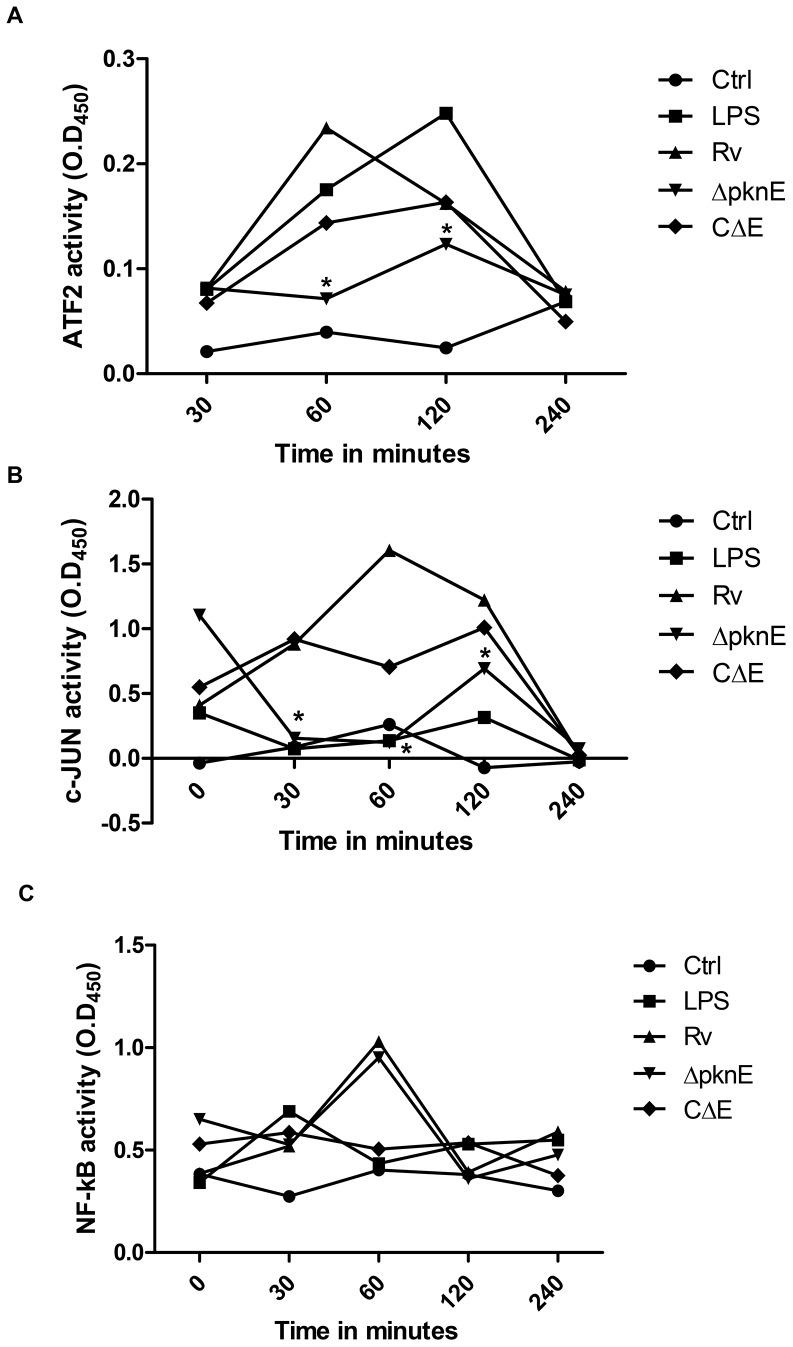
ΔpknE infected macrophages have reduced expression of transcription factors.Nuclear fractions isolated post infection was subjected to DNA binding ELISA for A) ATF-2, B) c-JUN, and C) NF-kB. The results from three independent experiments are shown. The O.D values denote standard error of the means. *denote p<0.05 (Two way ANOVA) when ΔpknE versus Rv infected macrophages were compared.